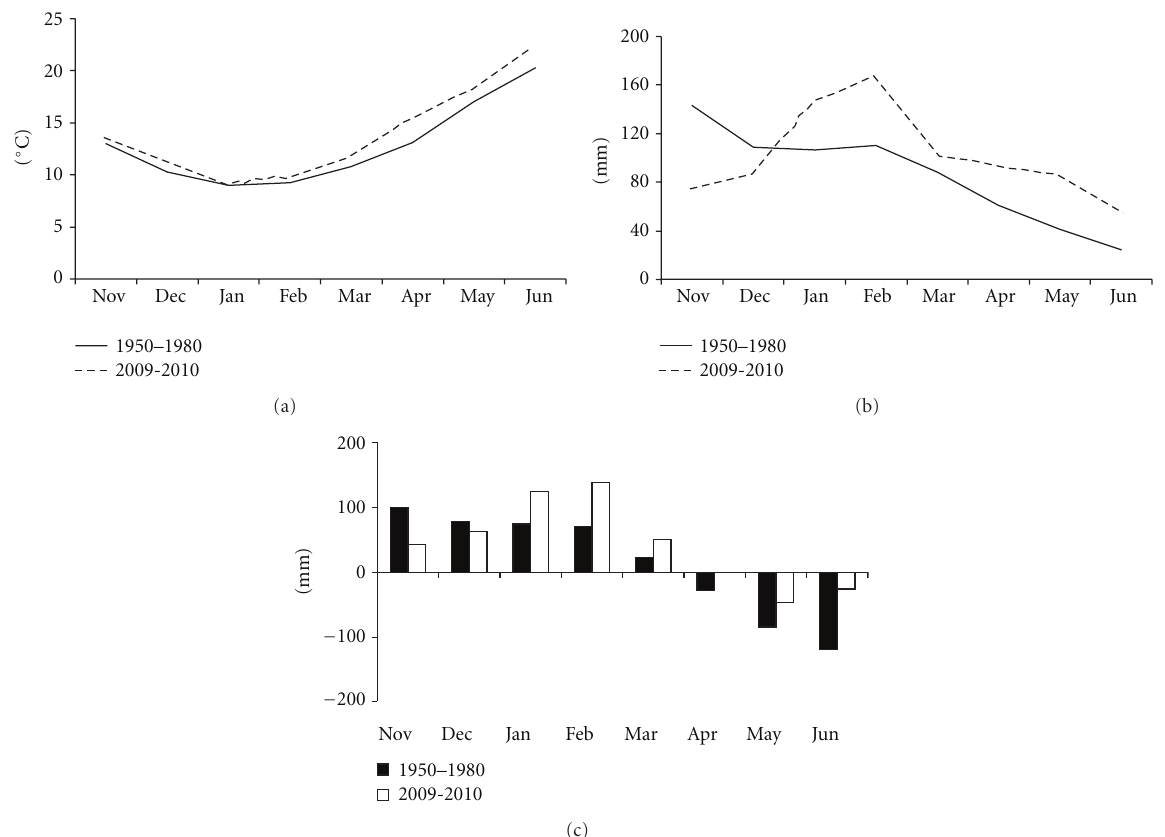
AB Analytical, Sweden). The grains were milled to wholemeal with a Cyclotec mill-PBI (Italy) and sieved with a 1 mm mesh; the protein contents were determined by Dumas combustion method (ICC method n. 167) with automatic instrument Leco FP 428 (USA). Sedimentation index was evaluated in sodium-dodecyl-sulphate, according with the ICC method n. 151 with SDS